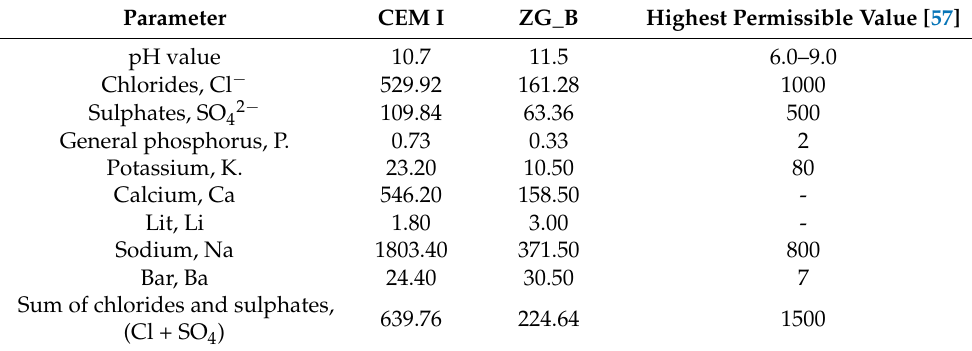
Table 9. Leachability of harmful substances for monolithic rock wool geopolymer mortar, expressed in mg/L dry weight (except for